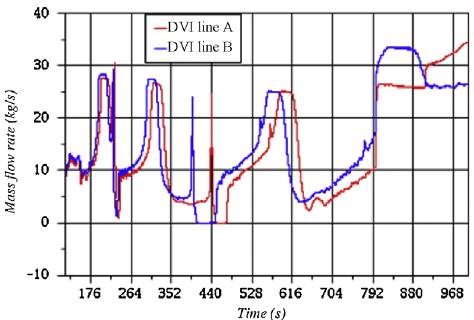
Fig. 18. Total injection mass fl ow from 120 s to 1000 s (kg/s).